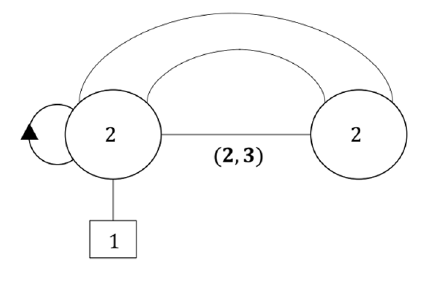
Figure 4 . A modi(cid:12)cation of the in (cid:12)gure 1 by the addition of an extra